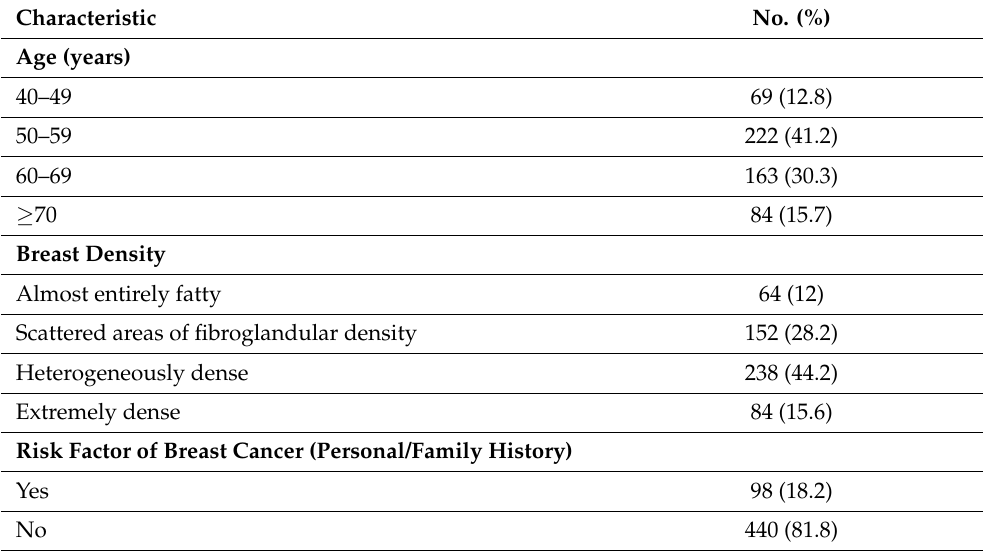
Table 1. Characteristics of women recalled for assessment following a suspicious mammography